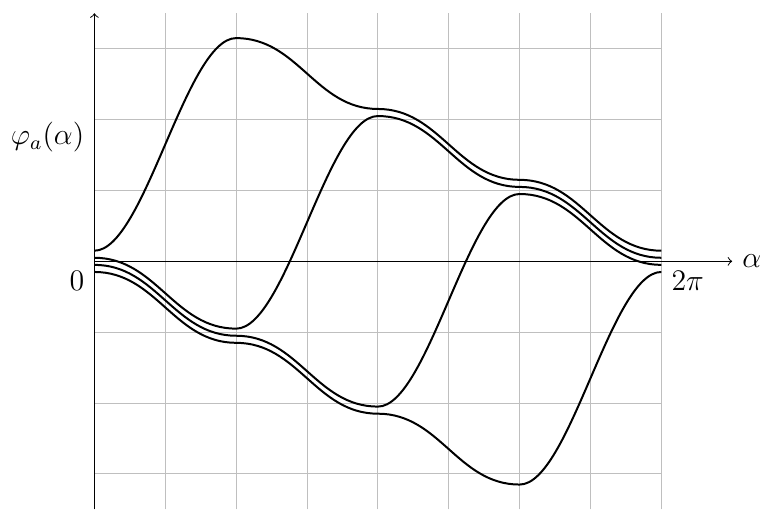
( α ) outside R = 4. We deliberately for N a f 2